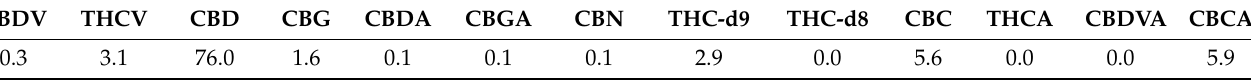
Table 4. Cannabinoid percentage in CBD-rich extract